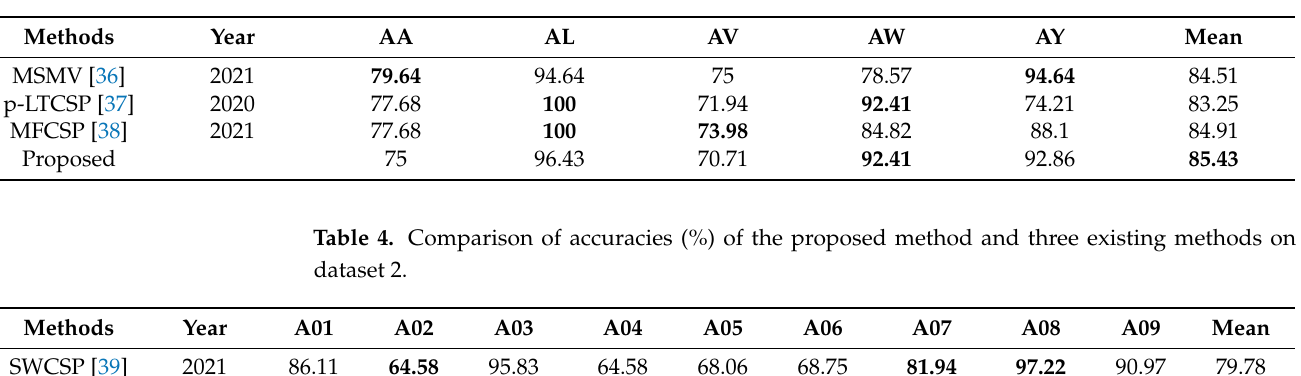
Table 3. Comparison of accuracies (%) of the proposed method and three existing methods on dataset 1.